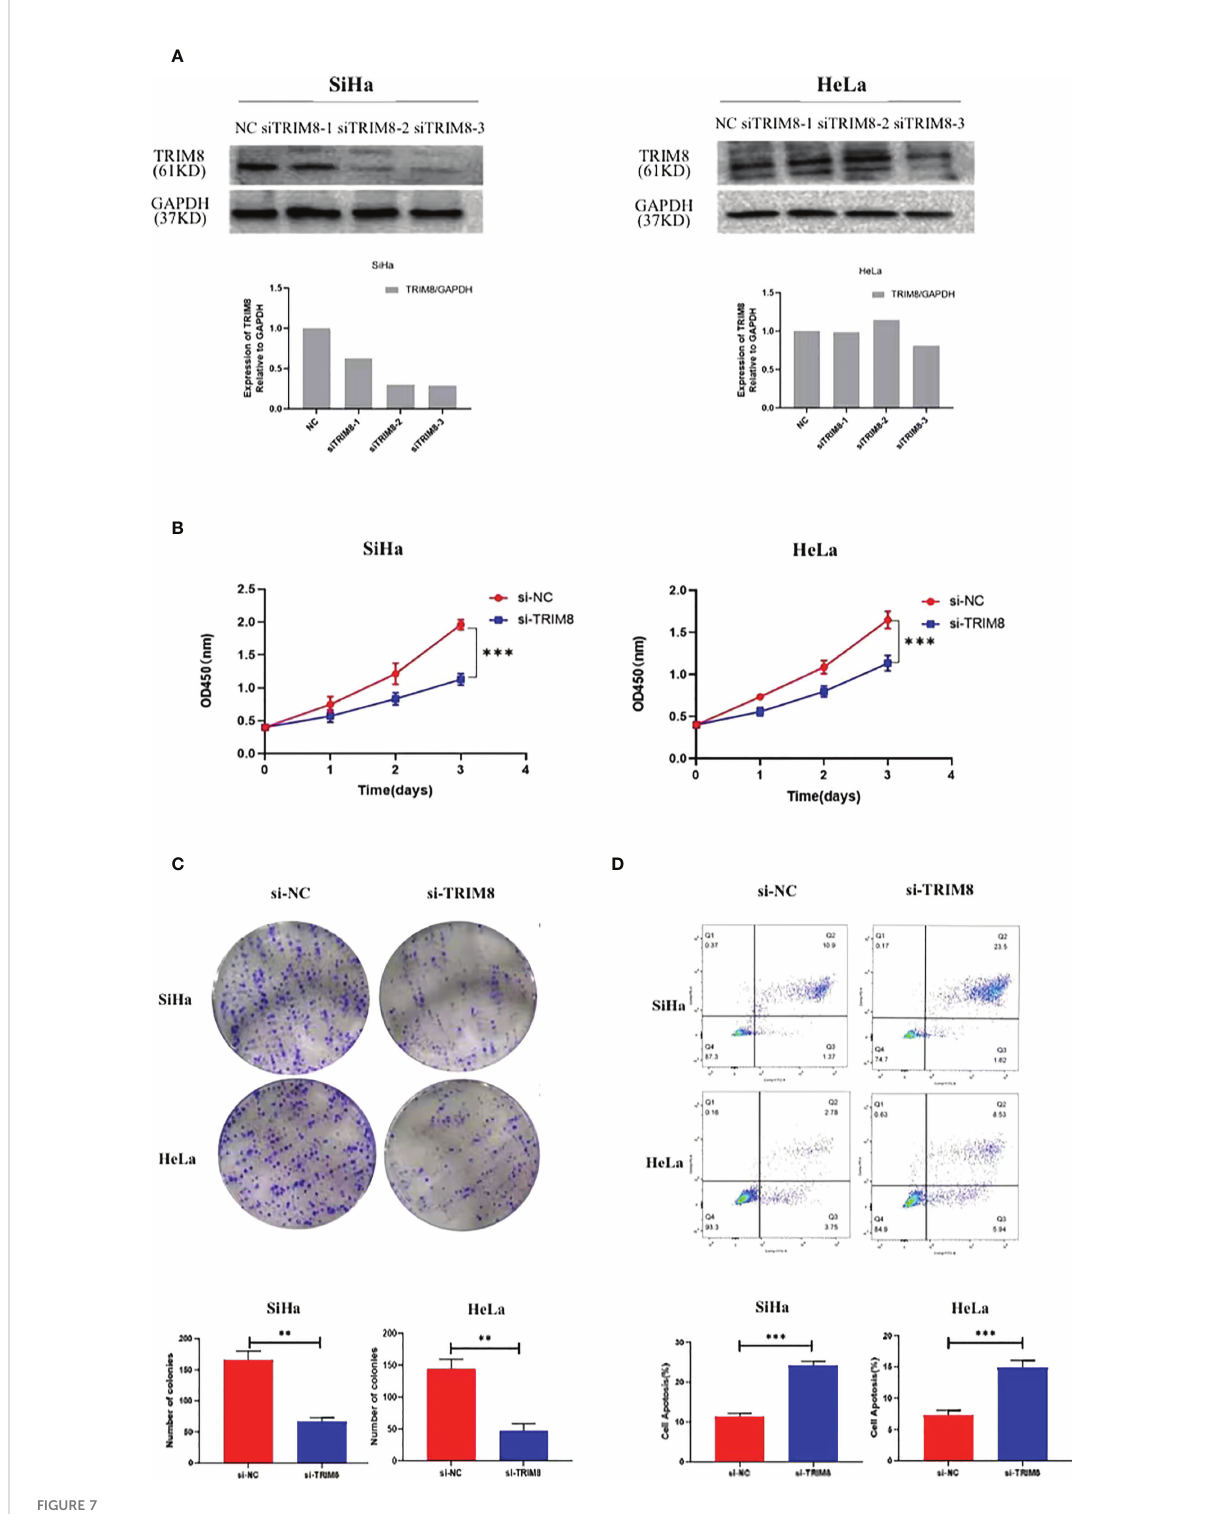
FIGURE 7 TRIM8 plays a role as an oncogene in cervical cancer. (A) Veri fi cation of interference ef fi ciency of TRIM8 in SiHa and HeLa cells, respectively. The bottom fi gures are the corresponding quantization diagrams. (B, C) CCK-8 and clone formation assays showed that down regulation of TRIM8 expression inhibited the proliferation of SiHa and HeLa cells. (D) Flow cytometry indicated that the silence of TRIM8 increased the apoptosis ratio of SiHa cells and HeLa cells. **p<0.01,